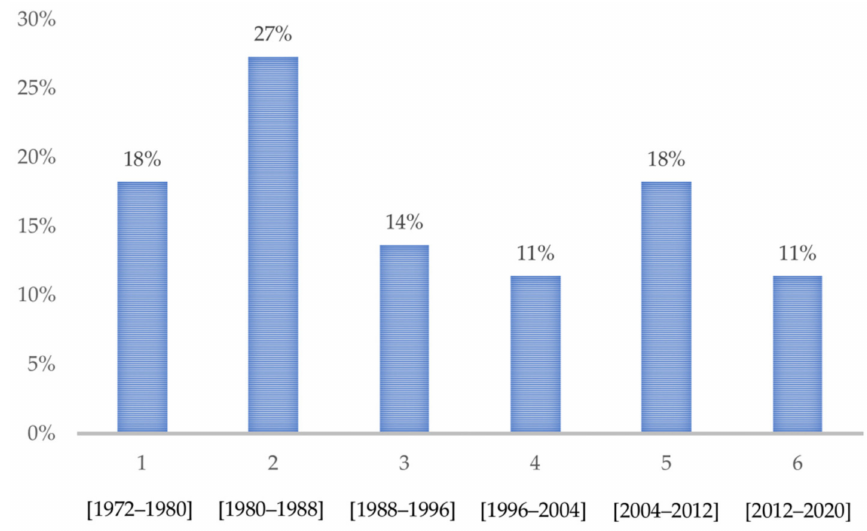
Figure 2. Percentage of studies identified during consecutive 8-year periods from 1972 to 2020.